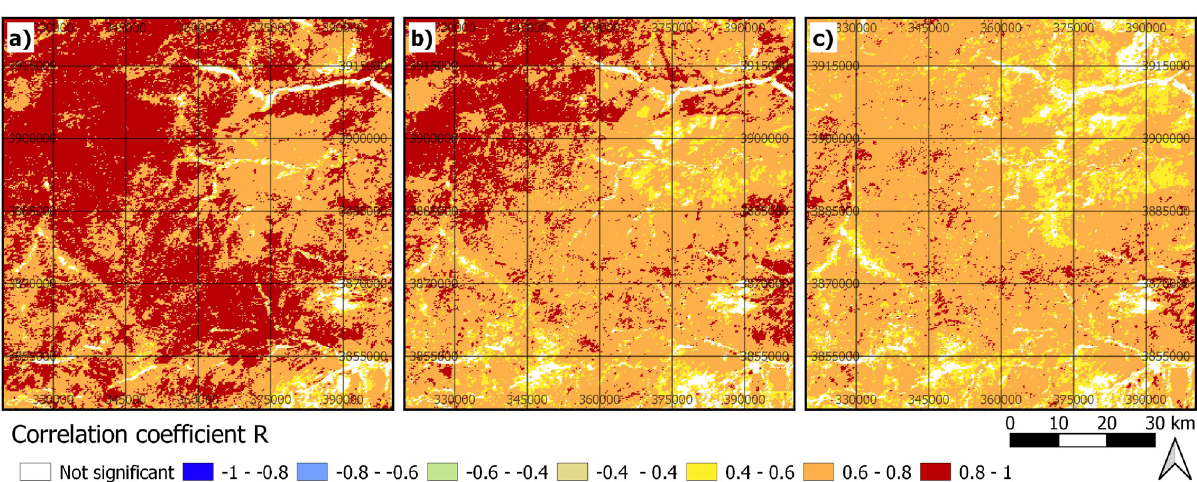
Figure 4. Significant Pearson’s correlation of ERA5-Land precipitation/ Hydrological-year ( a ), MERRA-2 precipitation/ Hydrological-year ( b ), and CRU precipitation/ Hydrological-year ( c ) in the Band-e-Amir region (projection: UTM zone 42 N). Created using QGIS 3.12 (http://qgis.osgeo .org/) 45